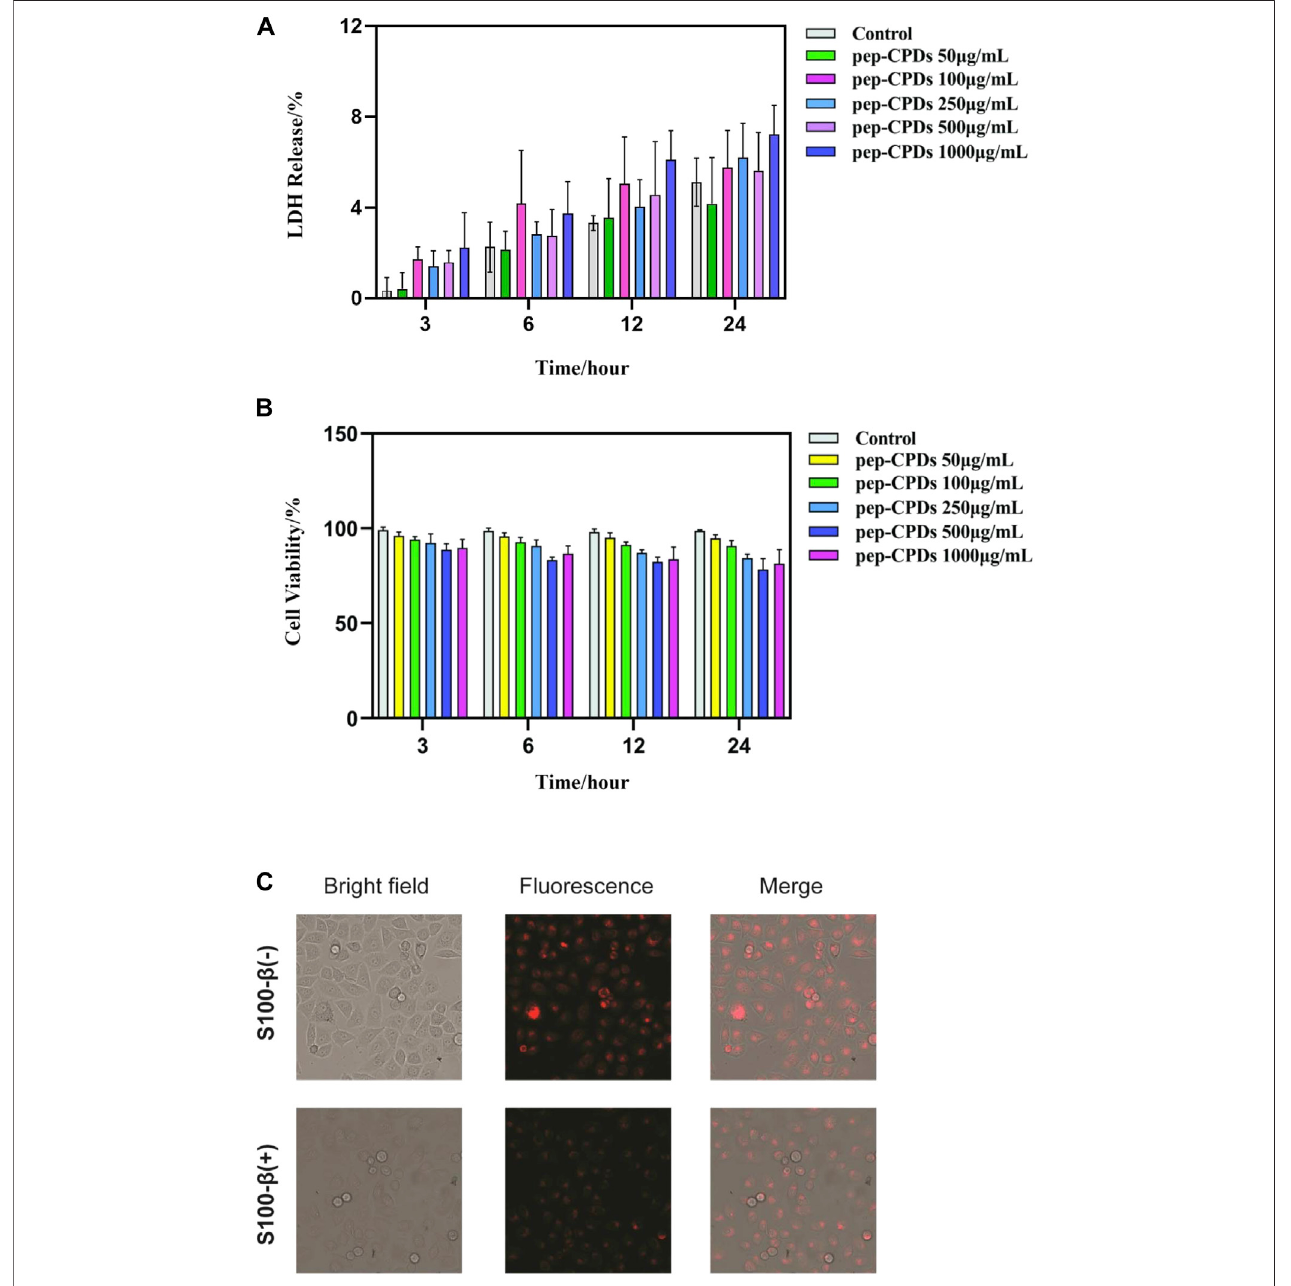
FIGURE 3 | The evaluation of CPDs effect on in vitro cell viability and its application in the cellular fl uorescence imaging. (A) . HeLa cells were treated with various concentrationsofpep-CPDs(rightpanel)for3,6,12,and24 h.TheLDHactivityincellsupernatantsorlysateswasanalyzedbytheCyQUANT ™ LDHCytotoxicityAssay Kit (ThermoFisher) according to manufacturers ’ protocol. Data are expressed as mean ± SD (n = 6). (B) . HeLa cells were treated with various concentrations of pep- CPDs (right panel) for 3, 6, 12, and 24 h. The cell viability was measured by the MTT assay. Data are expressed as mean ± SD (n = 6) (C) . Confocal images of the intracellularS100- β inthecontrolgroup/S100- β (-)andS100- β (+)group(scalebar=100 μ m).Multicolor fl uorescentcellimagingofHeLacellsincubatedwithpep-CPDs with S100- β and without in CLSM images, optical images, and merged images.